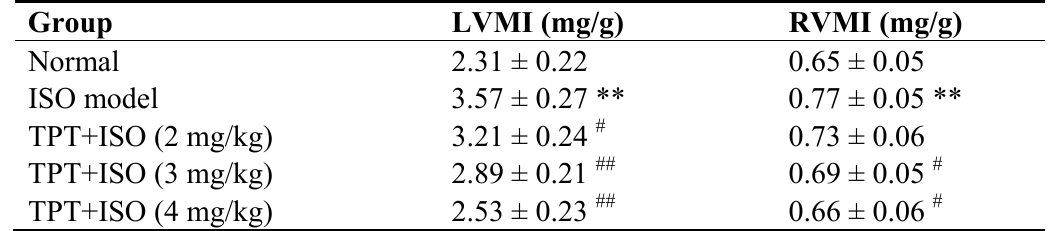
Table 2. Effect of TPT on LVMI and RVMI in all groups of